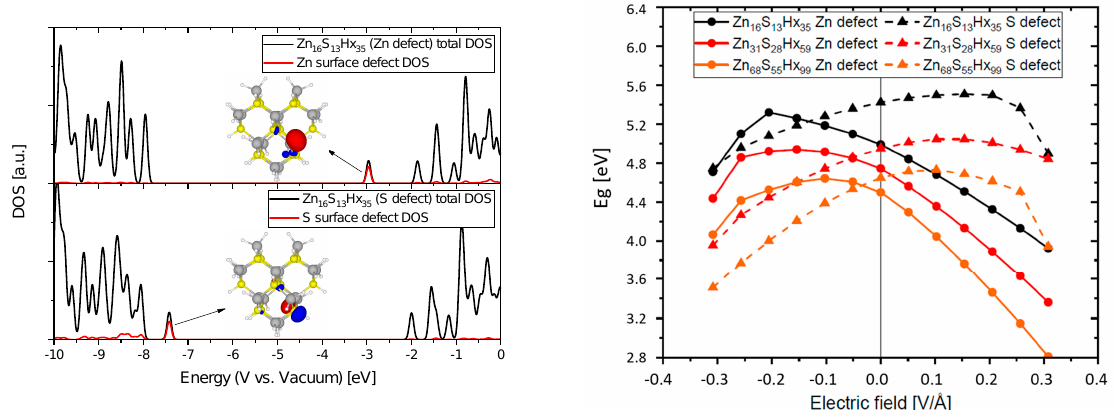
Figure 8. Density of states (DOS) and frontier orbitals of QDs with Zn and S surface defects ( left ) and the band gap E g of different sized QDs with surface defect states as a function of the applied electrical field ( right